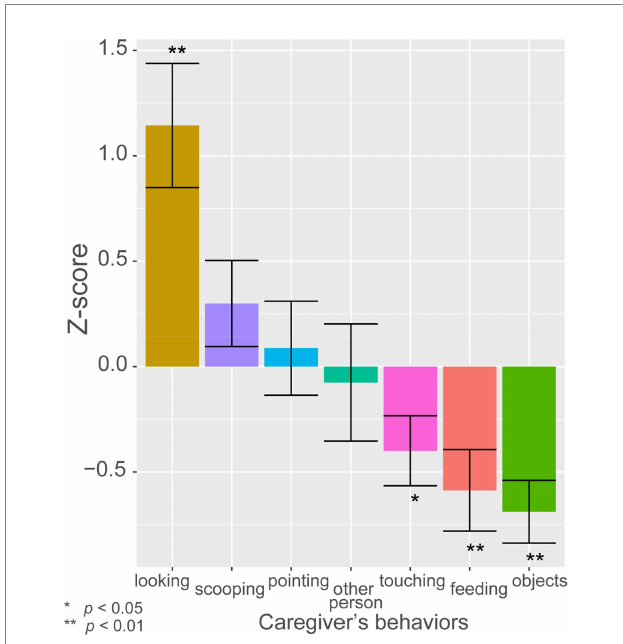
FIGURE 4 The z -scores of the difference between the expected frequency and the observed frequency of toddlers’ pointing during each category of caregiver’s behaviors. The figure is based on the data from the three observations of lunchtime for six children at two time points (13 months and 17 months of age). Error bars represent the standard error of the